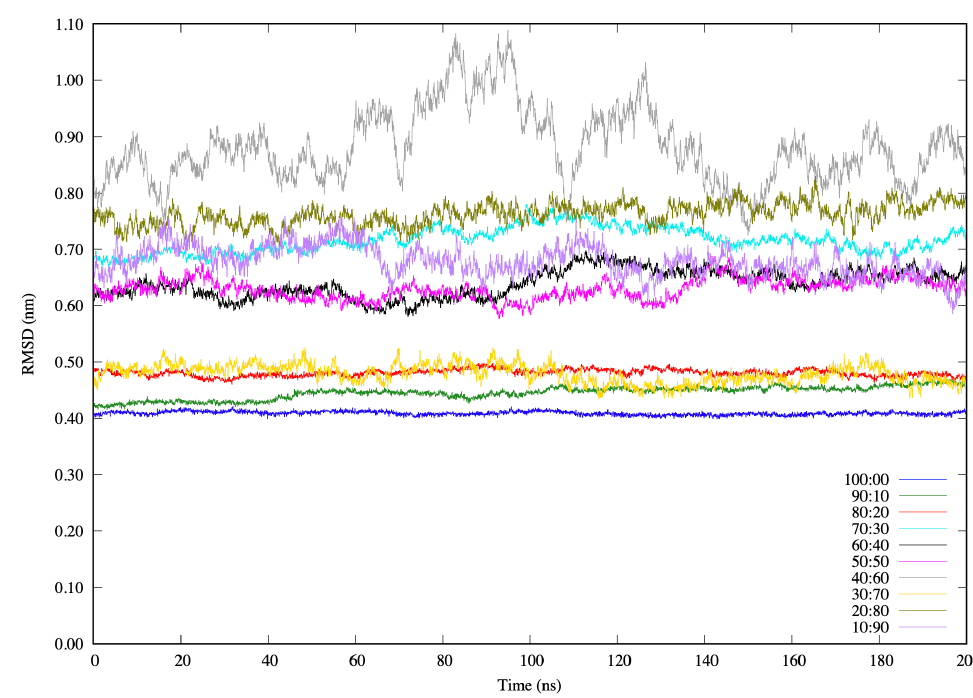
Figure 3. Conformational change in the RVFV protein domain measured as the root-mean-squared deviation